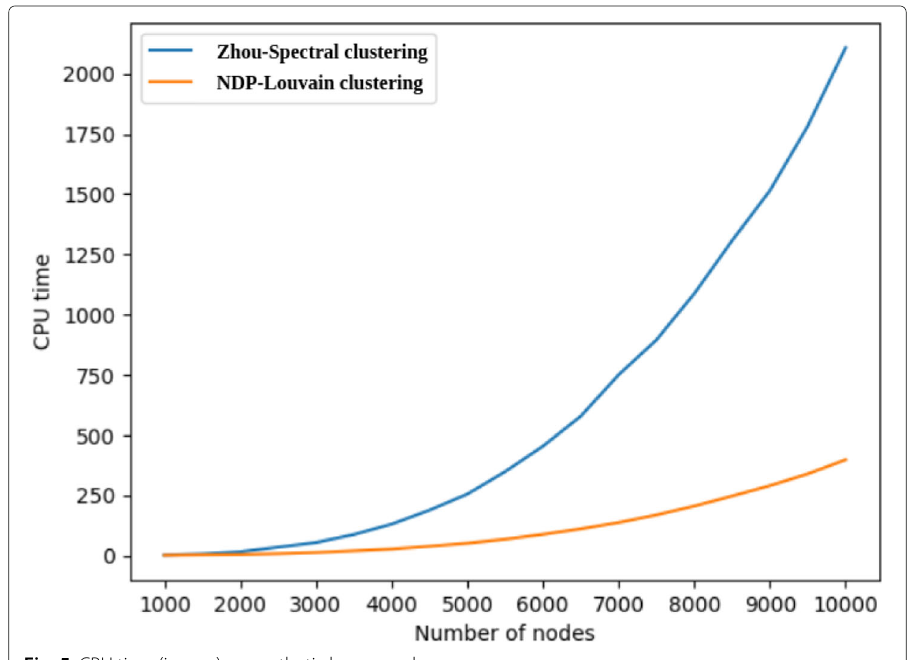
Fig. 5 CPU time (in secs) on synthetic